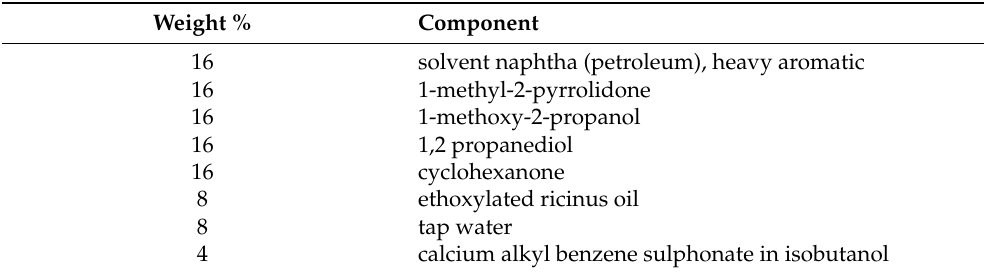
Table 1. Composition of the model liquid PFL-FR 2323 for plant protection products with indication in weight percent of their amount in the mixture [35,36].